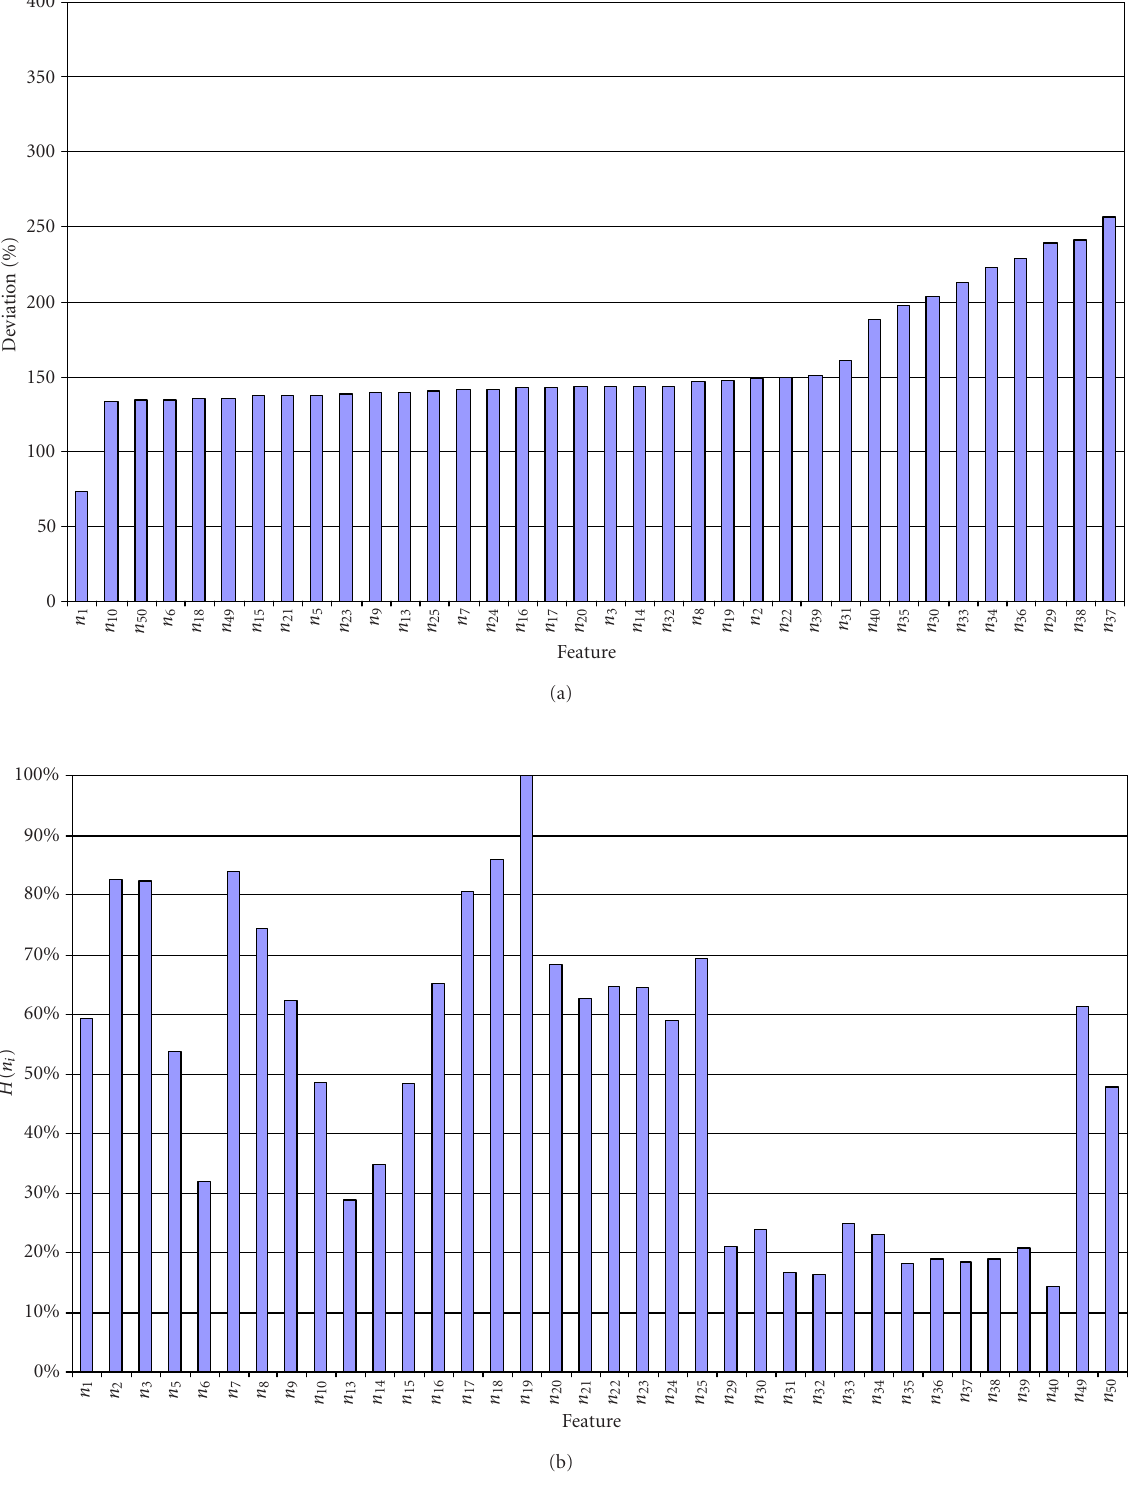
Figure 6: Sorted feature deviation histogram and relative entropy determined from extended test database. (a) Feature value deviations extended test. (b) Relative feature entropy of initial test based on H ( n 19) =